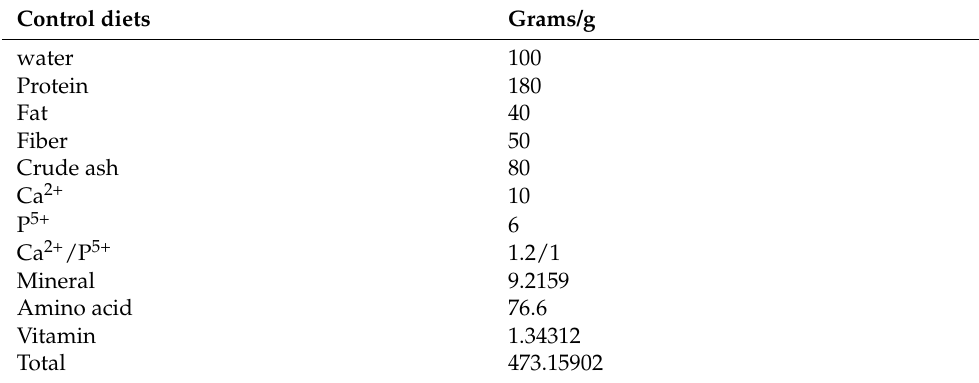
Table A1. Normal diets—Fat: 4.9%.